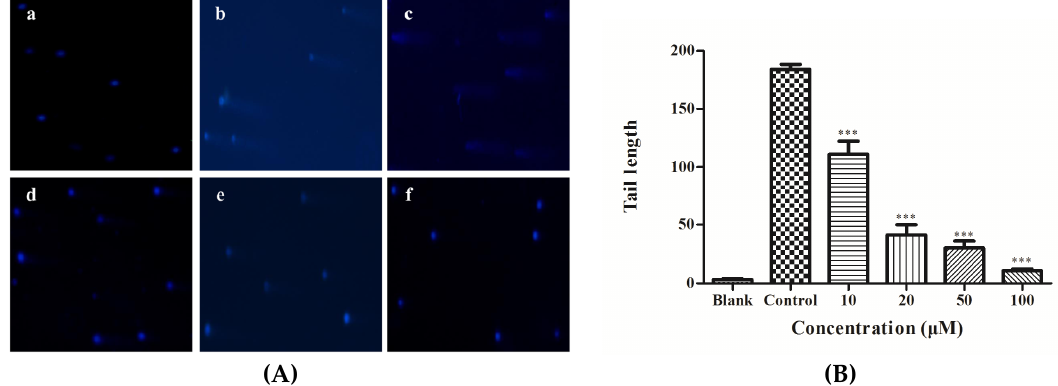
Figure 8. ( A ) Comet assay of (a) the blank group; (b) the control group; (c) 10, (d) 20, (e) 50, and (f) 100 µ M of YGDEY for 24 h prior to ethanol treatment for 2 h followed by staining with DAPI. Images were obtained using an inverted fluorescence microscope with blue fluorescence (magnification: 10 × ). ( B ) Tail lengths of the comets were analyzed. Data are shown as means ± SD ( n = 3). *** compared with the control group, p < 0.001.